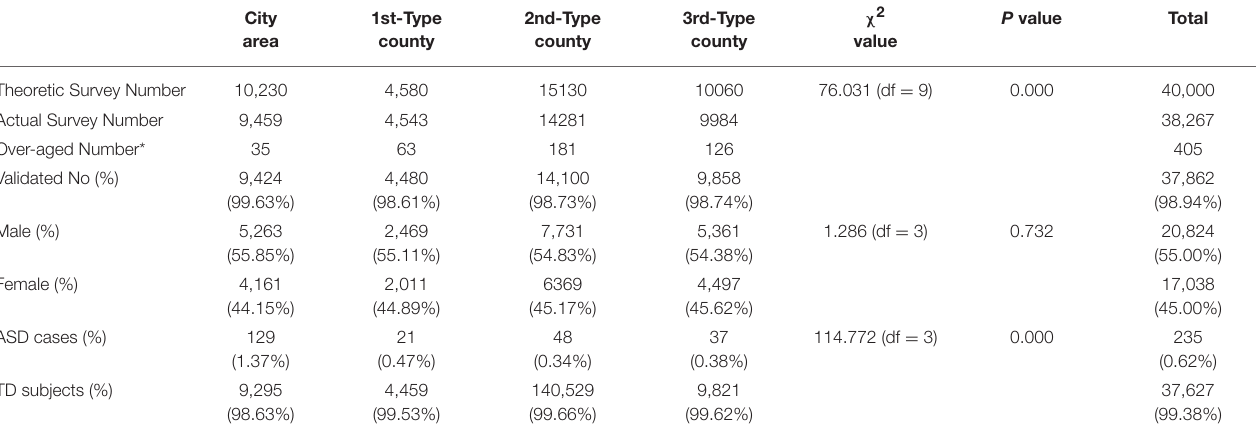
TABLE 2 | General information for the participants in the population-based ASD study.